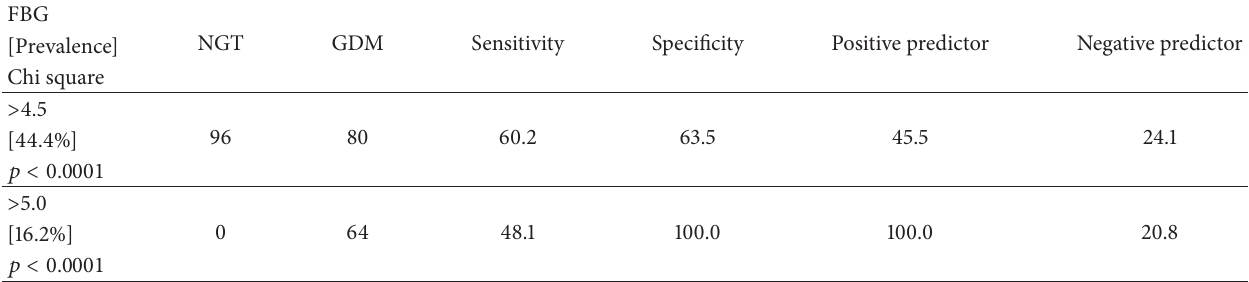
Table 3: Comparison between FBG values and the carbohydrate metabolic status along with the sensitivity, specificity, positive predictor, and negative predictor values at each FBG range.